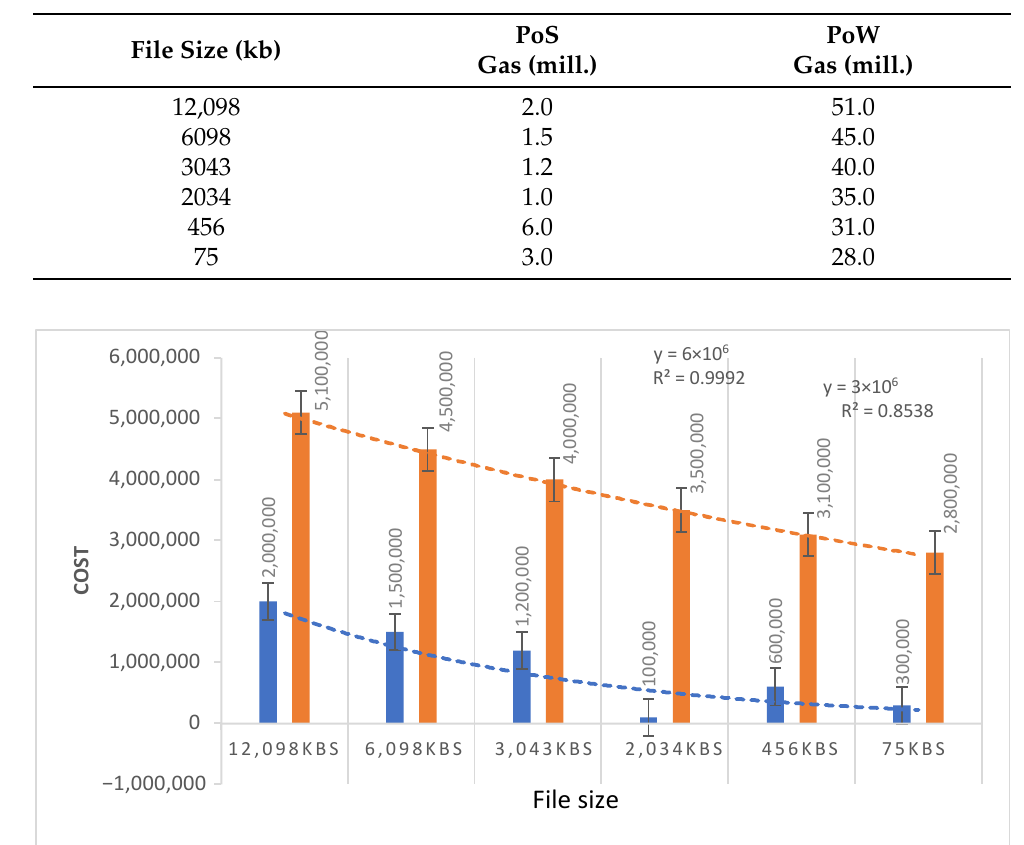
Figure 11. Comparison of smart contract deployment cost of PoW and